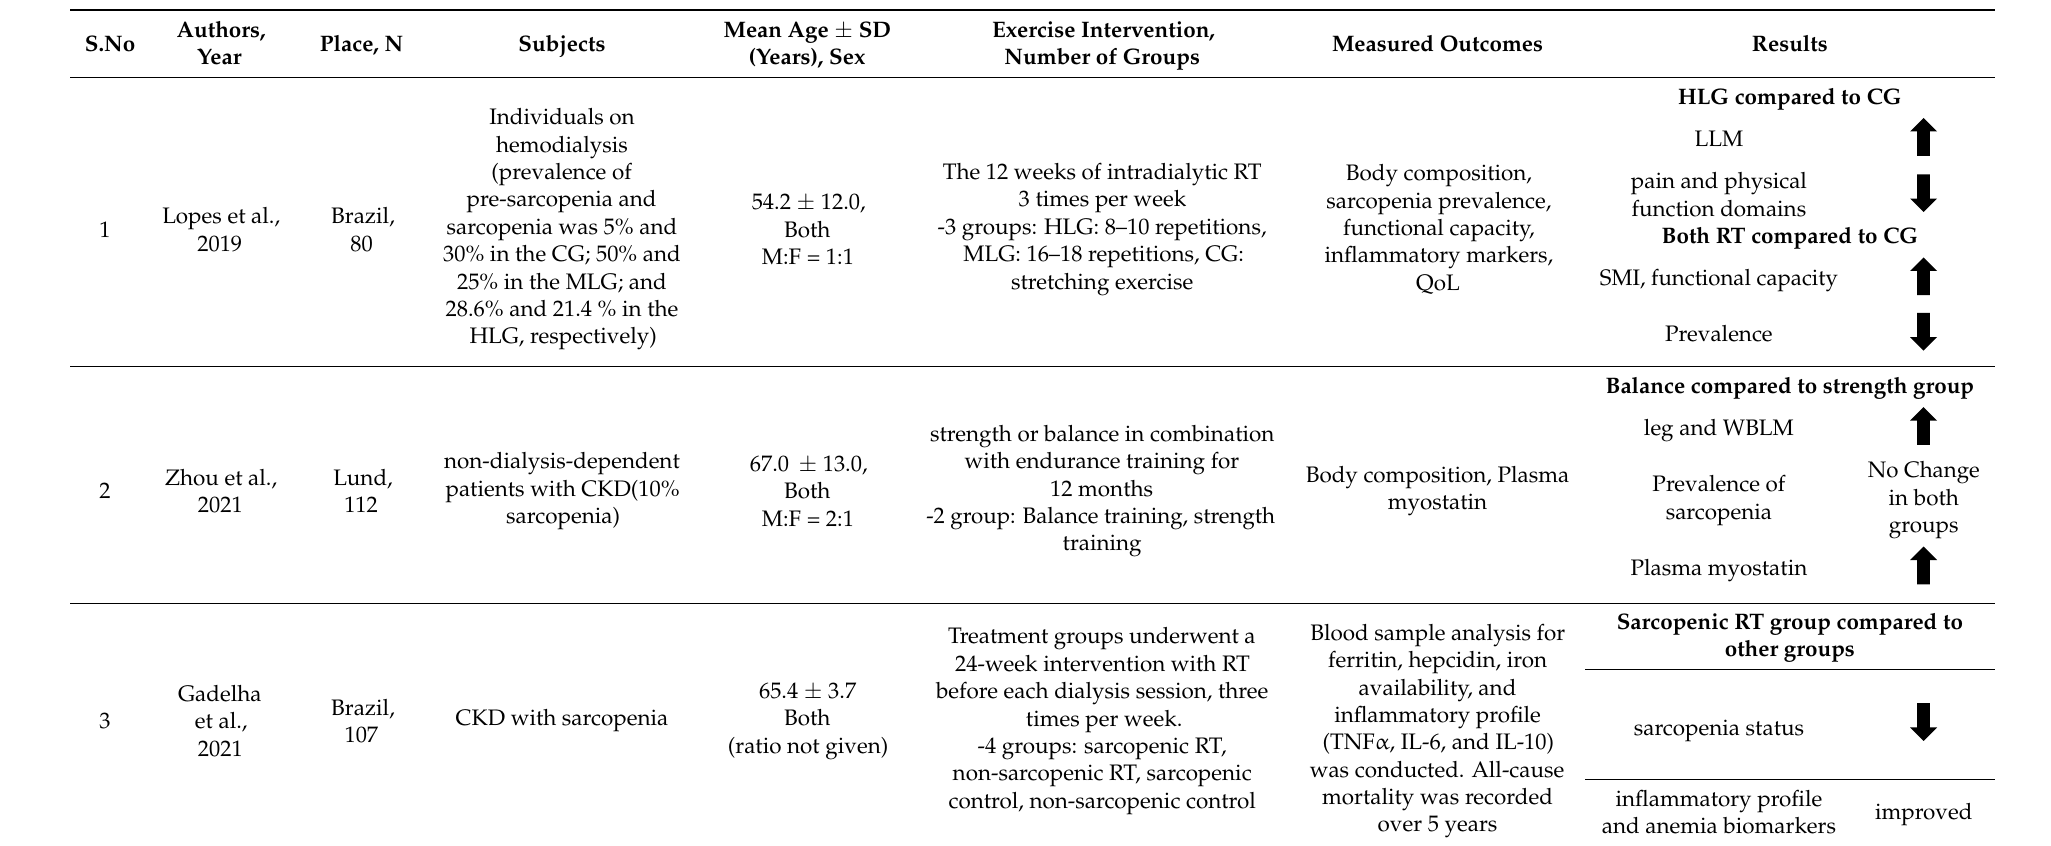
Table 1. Effect of exercise on subjects with cancer and baseline measurement of sarcopenia.